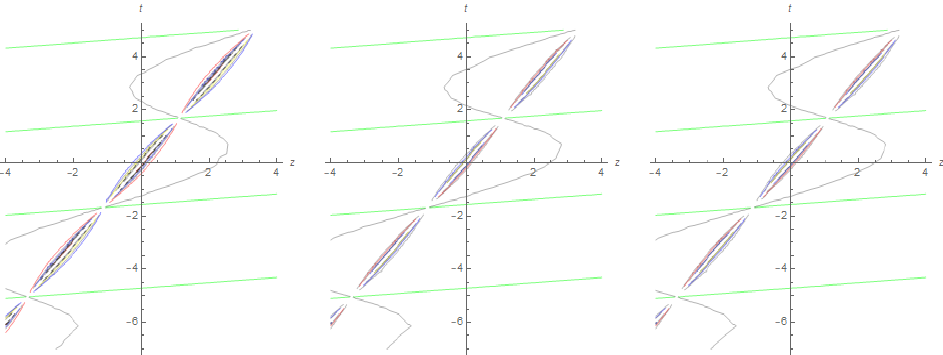
Figure 22. Contour slots for Figure